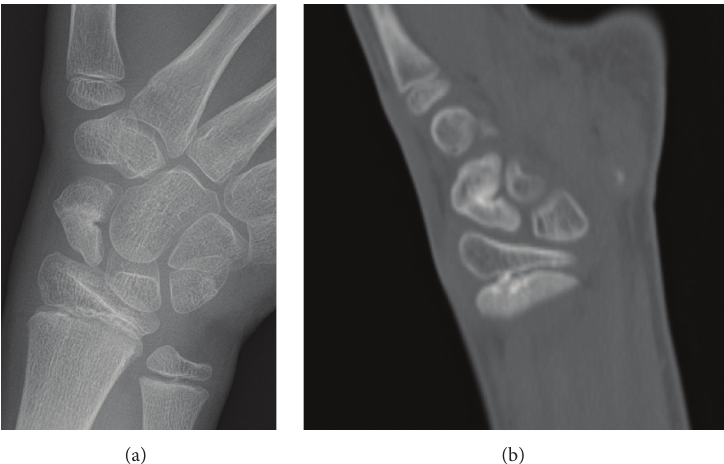
Figure 3: (a) Plain radiograph at the end of cast immobilization showing improved consolidation. (b) CT scan be performed one month after the end of cast immobilization showing union of the